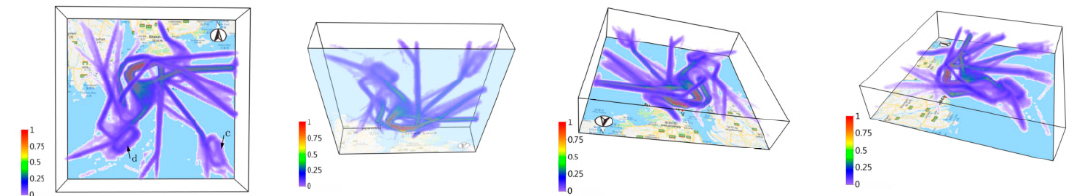
Figure 56. 4D time density of flight routes displayed in different directions [145].